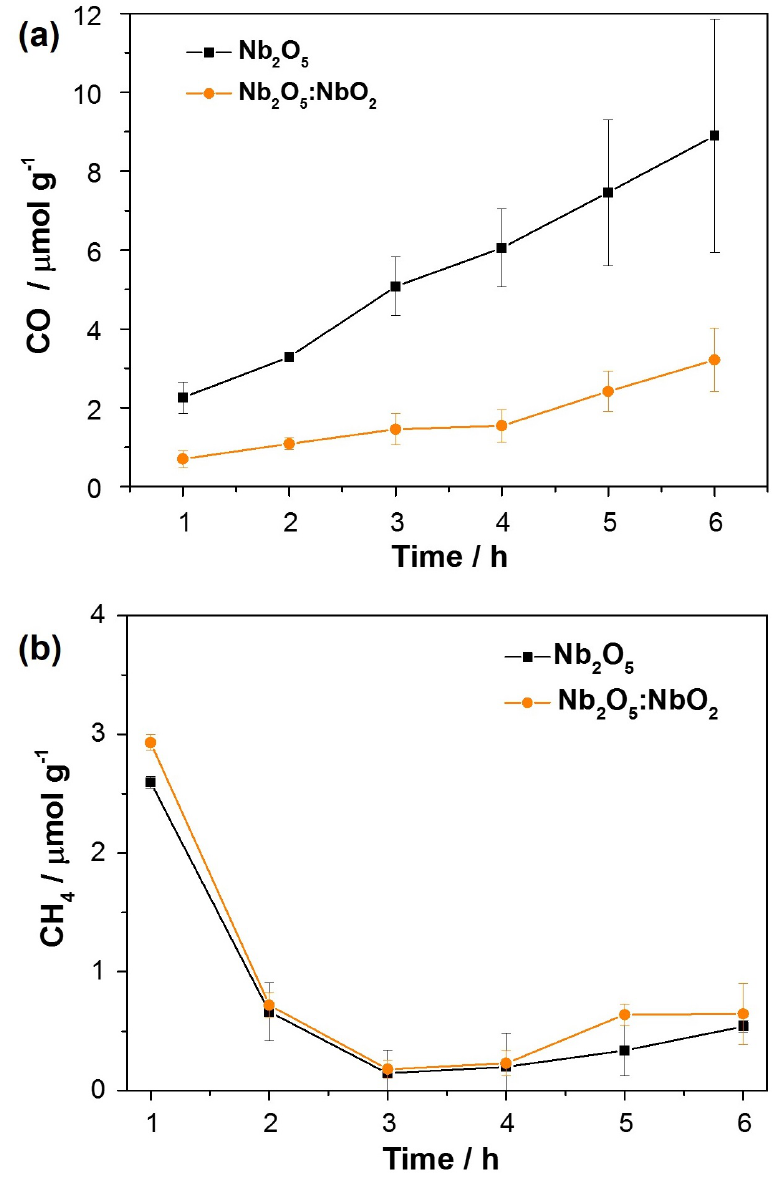
Figure 6. CO 2 gaseous photoreduction in ( a ) CO and ( b ) CH 4 during 6 h under UV-C irradiation. After the first photocatalysis cycle of Nb 2 O 5 and Nb 2 O 5 :NbO fibers, 3 reuse tests were performed to evaluate the stability of the samples. Figure 7 shows the production rate ( µ mol g − 1 h − 1 ) of CO and CH 4 per cycle and a decrease in the formation of both products over the consecutive